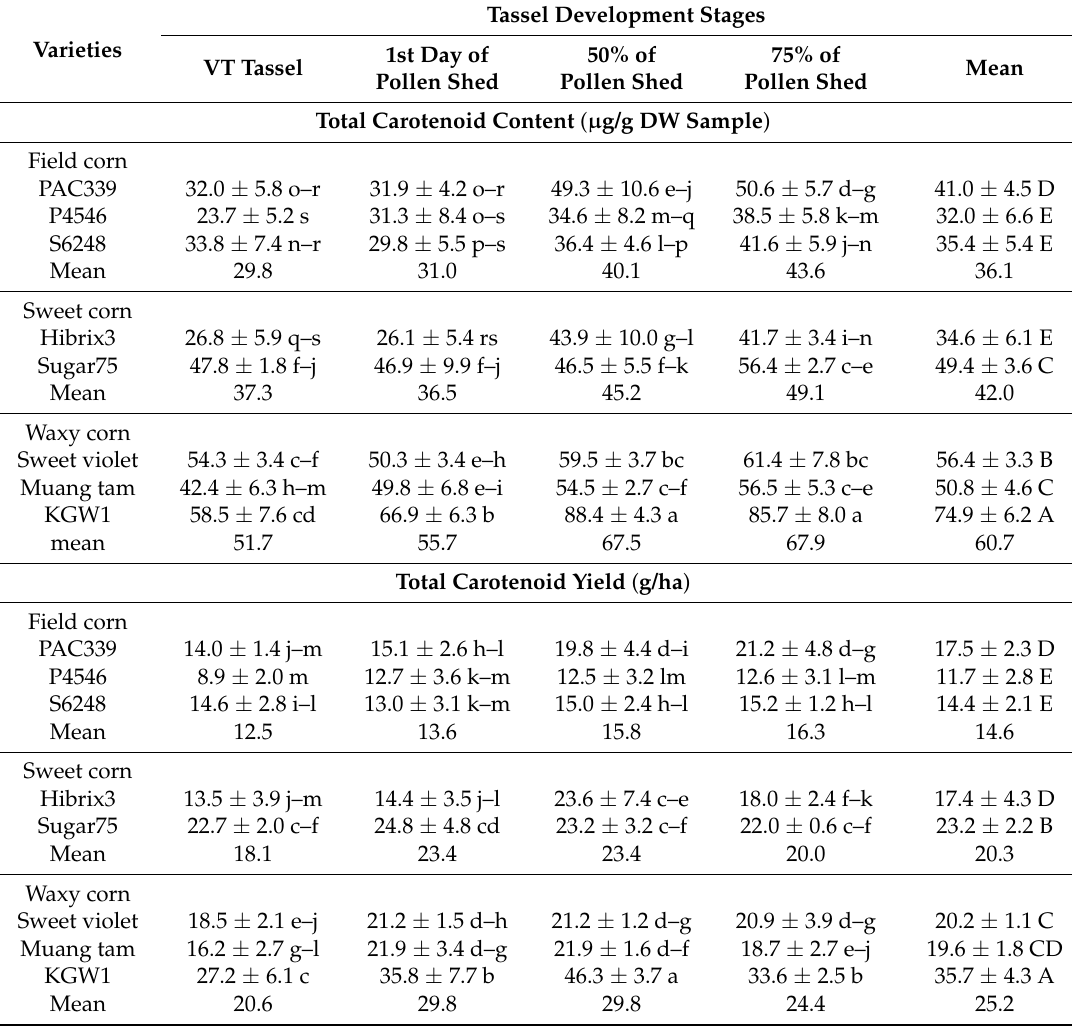
Table 5. Means of the total carotenoid content and total carotenoid yield in the tassels of eight corn varieties evaluated at four tassel development